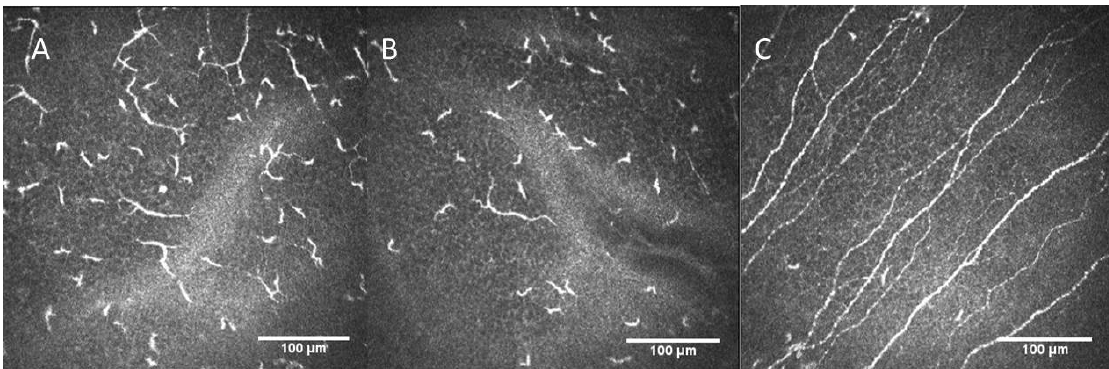
Figure 2. ( A ) Dendritic cell population in affected patient RE; ( B ) dendritic cell population in affected patient LE; ( C ) dendritic cell population in a patient without systemic pathologies or refractive surgery. RE: right eye; LE: left eye.